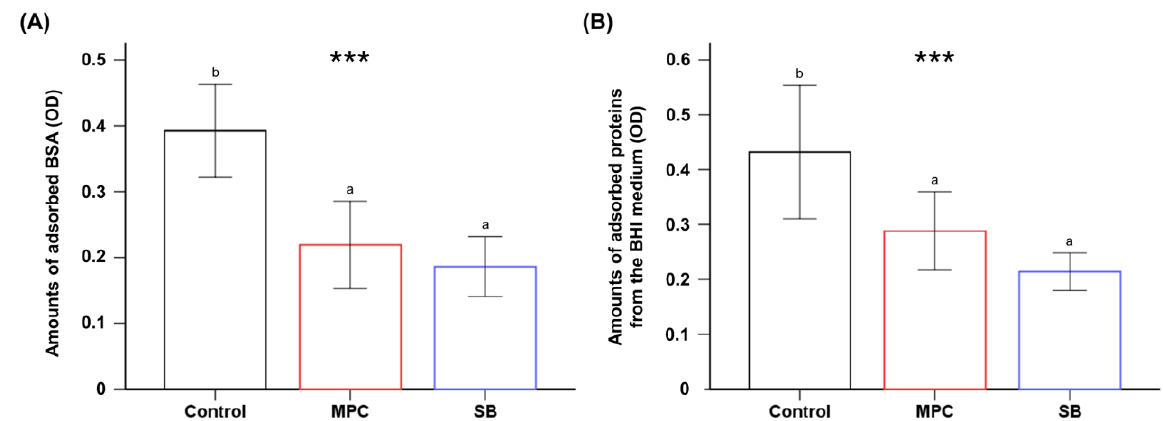
Figure 2. Comparison of the optical density (OD) of the adsorbed bovine serum albumin (BSA) ( A ) and protein adsorbed from the brain heart infusion (BHI) medium ( B ) of poly(methyl methacralyate) PMMA samples before (Control) and after the addition of 2-methacryloyloxyethyl phosphorylcholine (MPC) or sulfobetaine methacrylate (SB). Different lowercase letters above bars indicate significant differences by post-hoc Tukey’s test. *** p < 0.001 for comparisons between PMMA with and without the zwitterion analyzed by one-way analysis of variance (ANOVA).